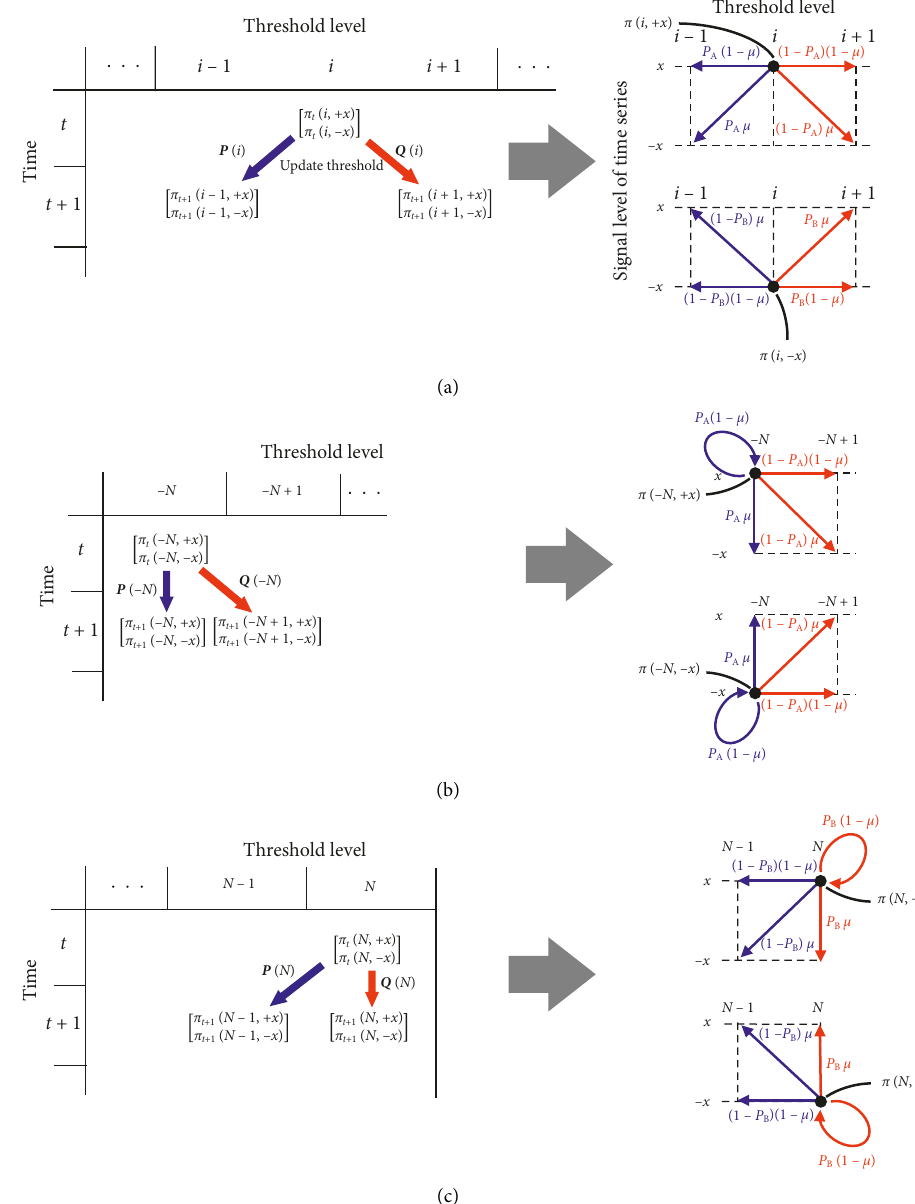
Figure 4: Transition probability vectors of the model. (a) The matrices of P and Q concern the increment and decrement of the threshold level. (b and c) When the threshold is at the edge ( − N or N ), transition to an identical threshold should be considered, which are represented by P ( − N ) and Q ( N ) in (b) and (c),